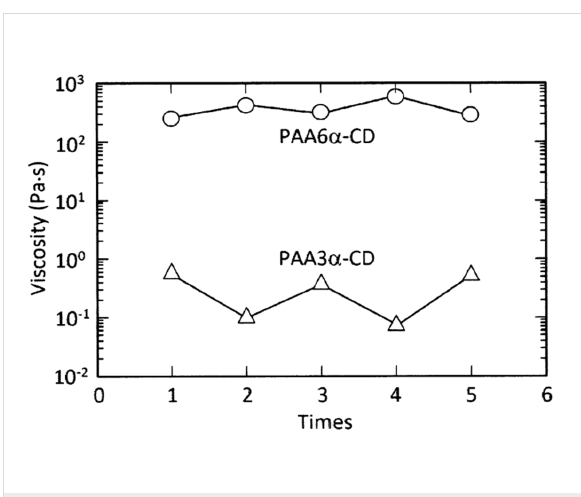
Figure 15: Variation of viscosity of a PAA6 α -CD/PAAAzo solution (circles) and a PAA3 α -CD/PAAAzo solution (triangles) during repeti- tive irradiations. For PAA3 α -CD/PAAAzo the low and high viscosity values are attained after UV and visible irradiation, respectively, and vice versa for PAA6 α -CD/PAAAzo. Adapted with permission from [67]. Copyright (2006) American Chemical